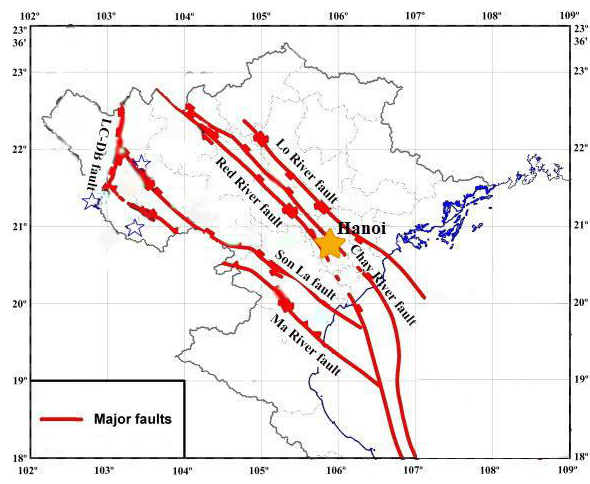
Figure 1. Map of major faults in the north of Vietnam [3].